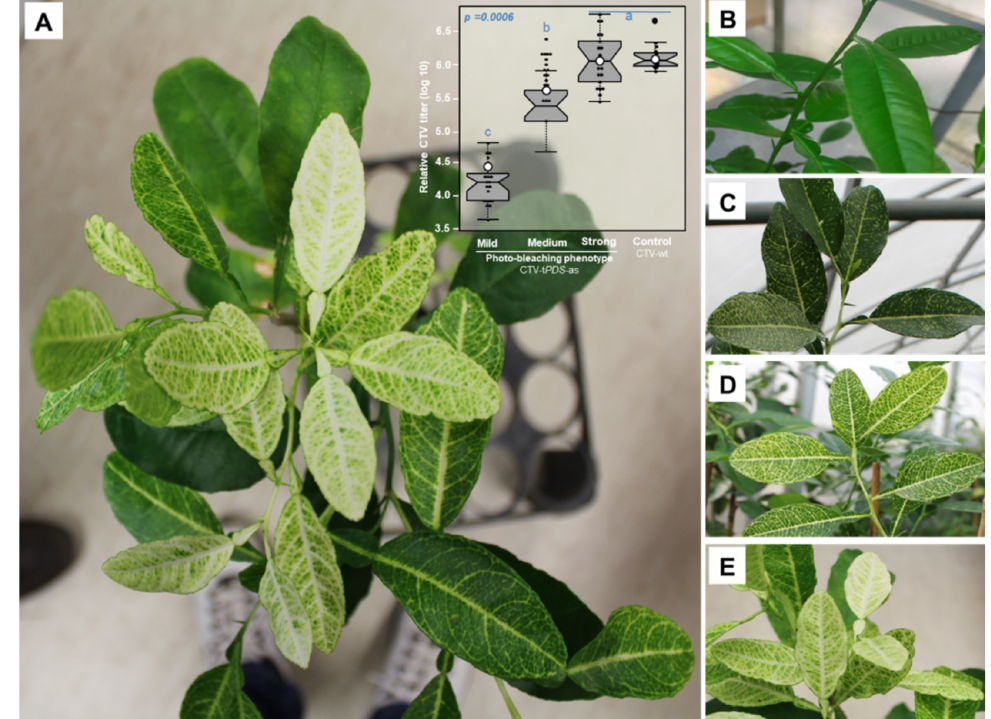
Figure 1. Silencing phytoene desaturase (PDS) causes a photobleaching phenotype in citrus plants: ( A ) photo showing the bleaching phenotype was not homogenous within the tree due to the unequal distribution of the Citrus tristeza virus (CTV)-t PDS -as vector. Note the different degrees of phenotype. The phenotype strength was correlated with the CTV titer (upper right corner in ( A )); ( B ) photo showing the control plant (CTV-wt) did not show a photobleaching phenotype; ( C ) photo showing the mild phenotype; ( D ) photo showing the medium phenotype; ( E ) photo showing the strong